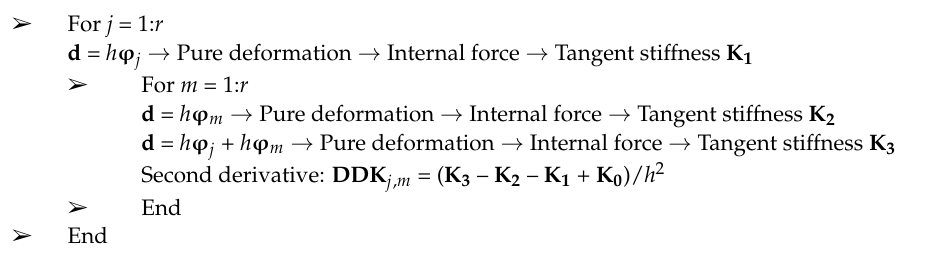
Algorithm 1 Algorithm to calculate the second-order derivative of nonlinear stiffness by forward difference